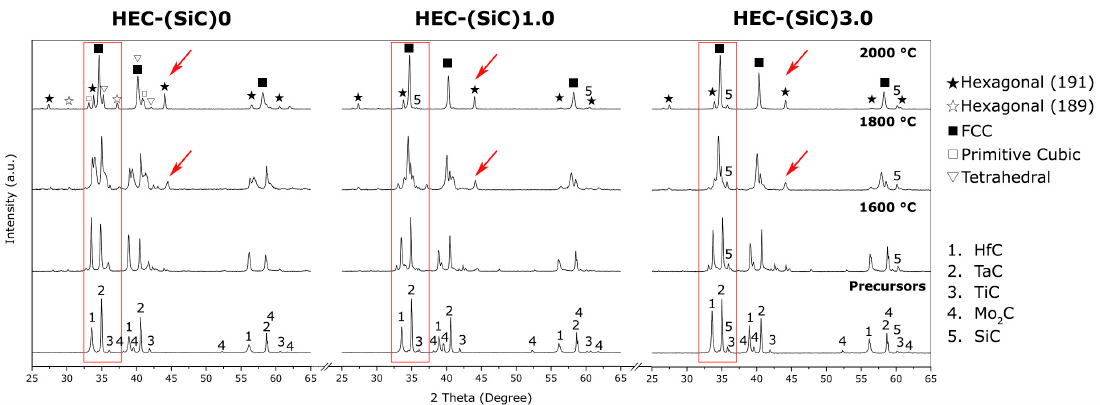
Figure 6. Composition evolution shown by X-ray diffractograms of HECs with temperature. The diffraction peaks of high-entropy face-centered cubic (FCC) and hexagonal phases start to be visible from 1800 °C.